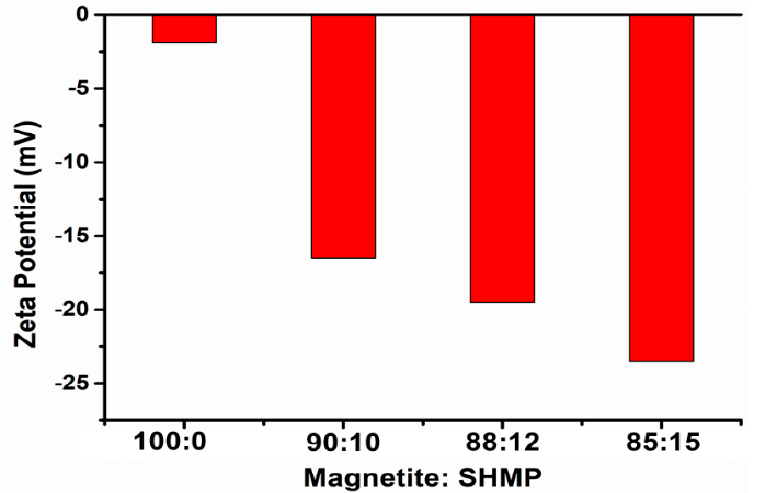
Figure 7. Zeta potential plot of bare Fe 3 O 4 and SHMP-treated Fe 3 O 4 by varying the Fe 3 O 4 and SHMP ratio.